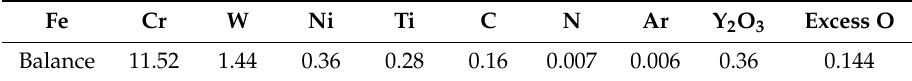
Table 1. Chemical composition of as-received dual-phase 12Cr oxide-dispersion-strengthened (ODS) alloy (wt